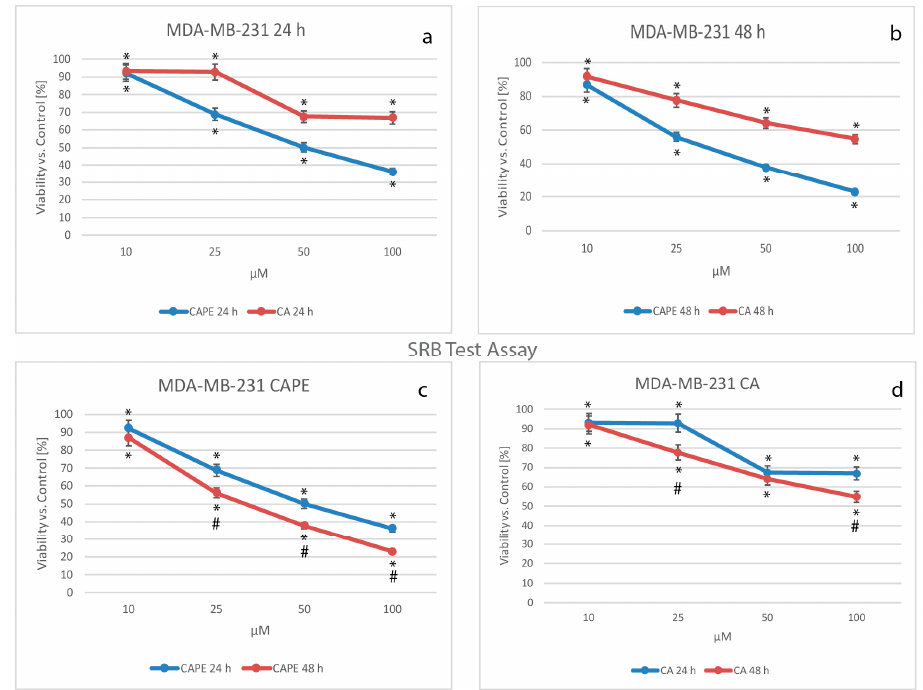
Figure 4. Figure 4. Viability results of the SRB (Sulforhodamine B) assay of caffeic acid phenethyl ester (CAPE) and caffeic acid (CA) at concentrations of from 10 to 100 µM for 24 h and 48 h incubation times on the breast cancer cell line MDA-MB-231. Like the XTT (2,3-bis[2methoxy-4-nitro-5-sulfopheny]-2H- tetrazolium-5-carboxyanilide inner salt) and NR (neutral red) tests, there was a visible dose- levels’—a first for 10 and 25 µM and a second ( d ), for 50 and 100 µM; this phenomenon could be explained by nonlinear absorbance; however, within a 48 h experiment it does not exist. Greater cancer cell mortality using CAPE rather than CA started again (just as with XTT and NR) from a dose